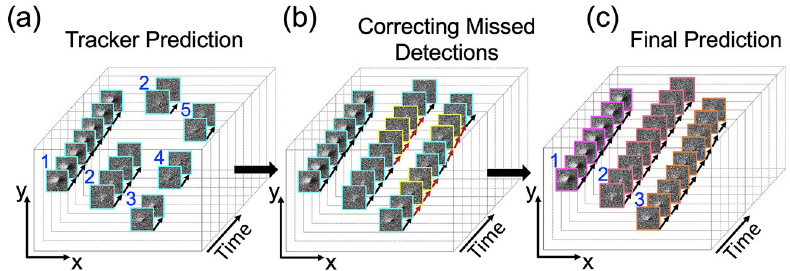
Figure 4. Schematics of the second level of tracking with a visual tracker. ( a ) An example of tracker prediction after the first level of tracking. Some defect cluster tracks are fragmented mainly due to missed detections (False Negatives) and it increases the chances of identity switches (ID SW: ID#3, 4, 5 are assigned to the same defect cluster). ( b ) The correction of missed detections by the visual tracker. Corrected missed detections are outlined in yellow. ( c ) The final output of DefectTrack shows uninterrupted and accurate tracking of three defect clusters with unique IDs throughout their